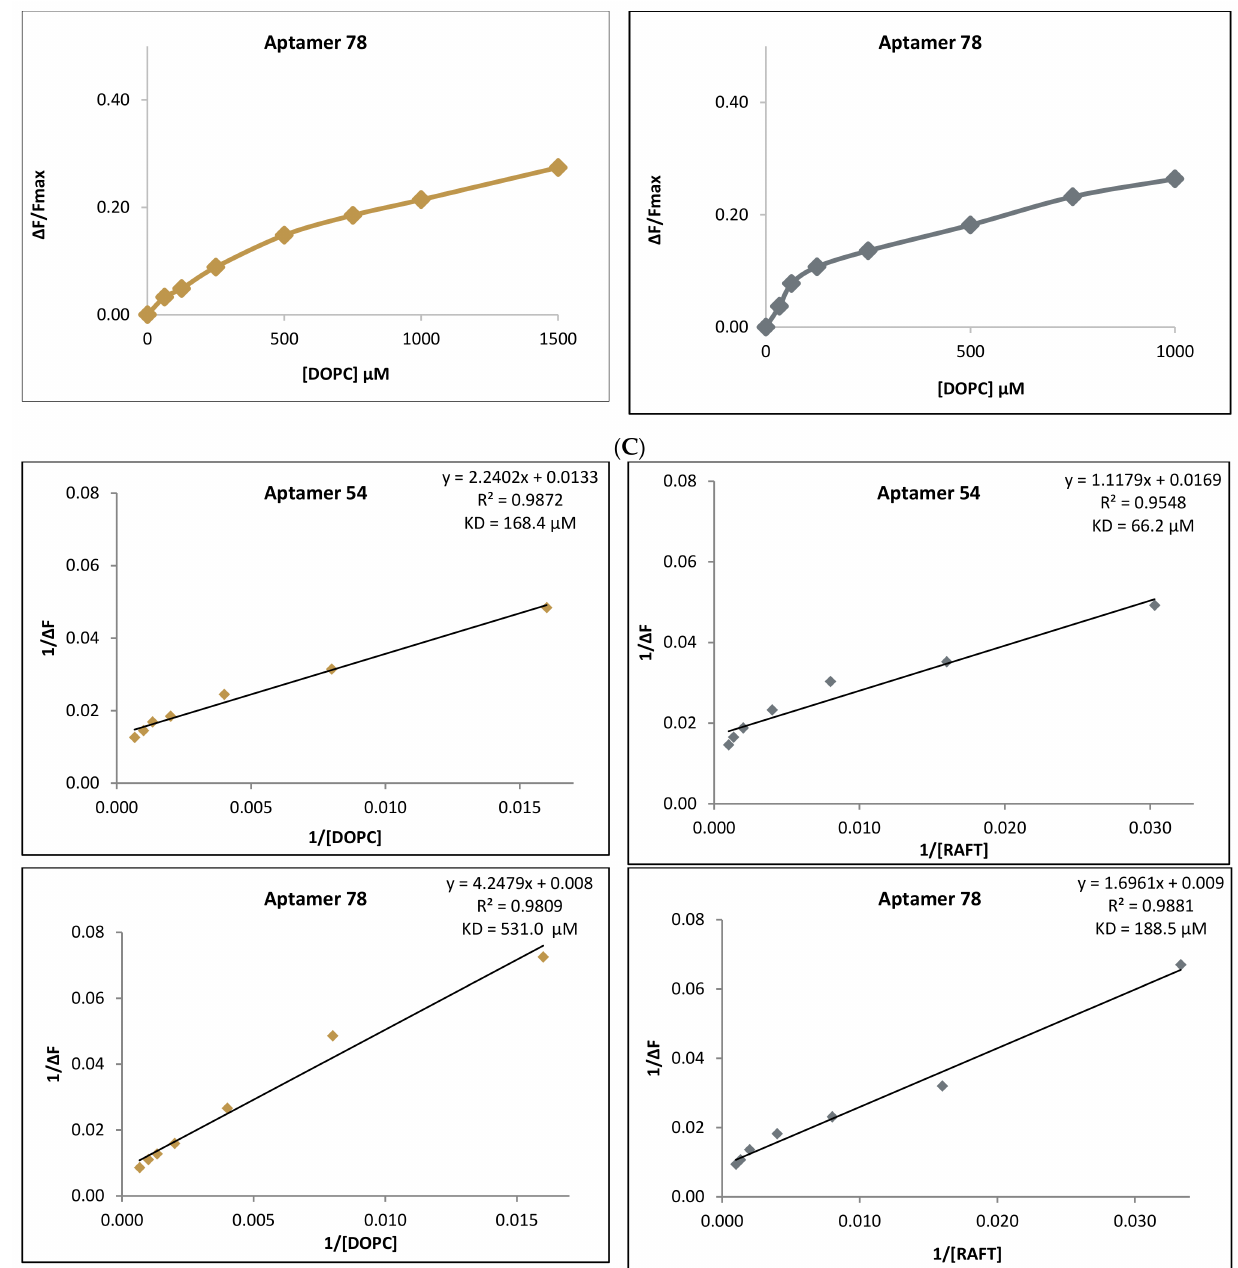
Figure 1. The interactions of YOYO-1-labeled RNA aptamers 54 and 78 with DOPC or RAFT liposomes. ( A ) Emission spectra of aptamer bound YOYO-1 (excitation at 466 nm), titrated with DOPC liposomes (0 µ M–1500 µ M) (left) and RAFT liposomes (0 µ M–1000 µ M) (right). The fluorescence intensity of YOYO-1 decreases with the increase in liposome concentration, for both aptamers 54 (top chart) and aptamer 78 (bottom) indicating the energy transfer to the membrane-bound acceptor (Liss Rhod PE). RNA aptamer concentration 0.25 µ M, YOYO concentration 2.5 µ M. ( B ) Change of YOYO-1 fluorescence during titration of RNA aptamer 54 (top) and RNA aptamer 78 (bottom) with DOPC liposomes (left) or RAFT liposomes (right). F max is the maximal YOYO-1 fluorescence obtained before acceptor-liposome titration. ∆ F is the difference between measured fluorescence and F max ( C ). Reciprocal of YOYO-1 fluorescence change during titration with DOPC (in left) or RAFT (right) liposomes. The calculated K D values indicate stronger RNA aptamer interaction with RAFT liposomes. For RNA aptamer 54—membrane measurements (top), the K D values are 168.4 µ M and 66.2 µ M with the interaction with DOPC and RAFT liposomes, respectively; for RNA aptamer 78, the K D values are 530.0 µ M and 188.5 µ M for interaction with DOPC and RAFT liposomes, respectively. The regression line equation and the coefficient of determination (R 2 ) are noted above the calculated K D value in the top-right corner of the